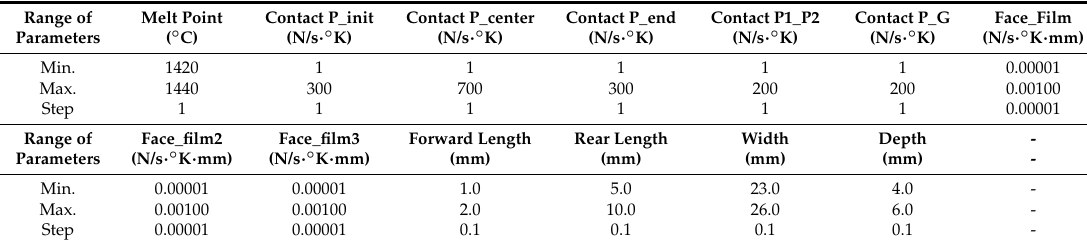
Table 3. Range considered for each of the input parameters of the FE models studied. Range of